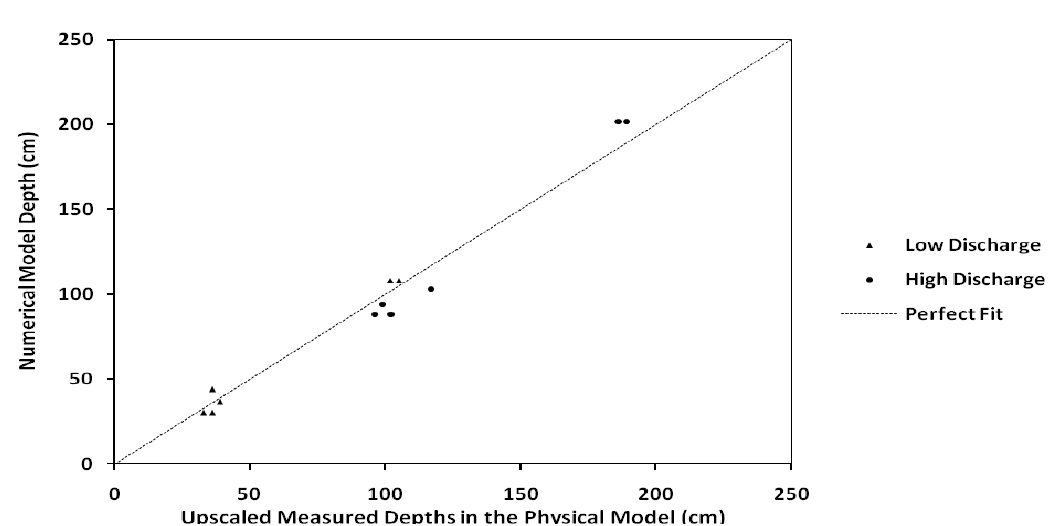
Figure 10. Upscaled measured depths vs. simulated values after